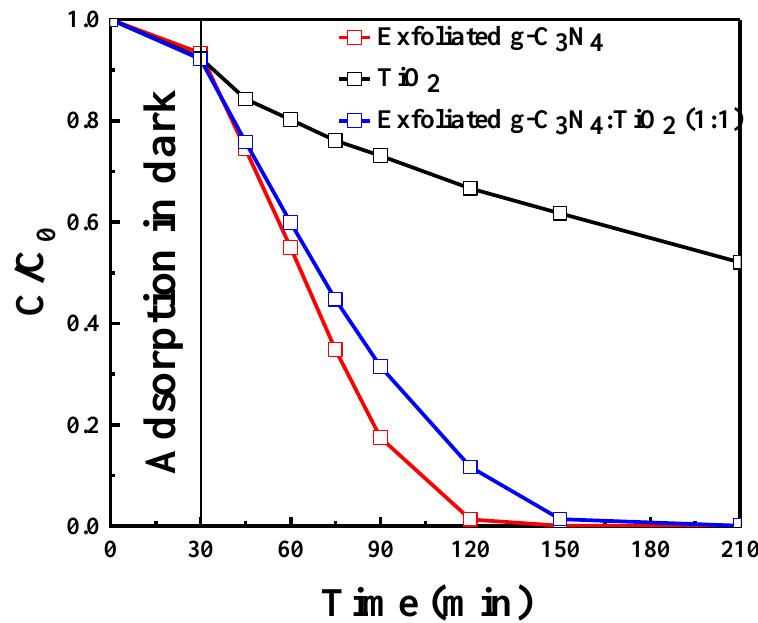
Figure 11. Phenol degradation with exfoliated g -C 3 N 4 , TiO 2 , and a g -C 3 N 4 :TiO 2 composite; C 0 = 20 ppm, airflow = 50 mL/min, catalyst = 0.5 g/L, pH = natural, light source = LEDs, Catalyst = exfoliated g-C 3 N 4 .